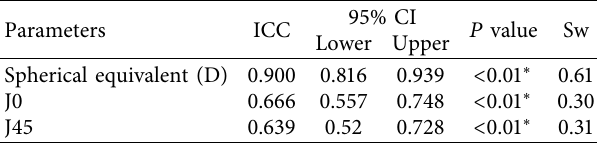
Figure 3: (a) Bland–Altman plot for spherical equivalent. (b) Bland–Altman plot for J0. (c) Bland–Altman plot for J45. Table 3: Reliability and repeatability of